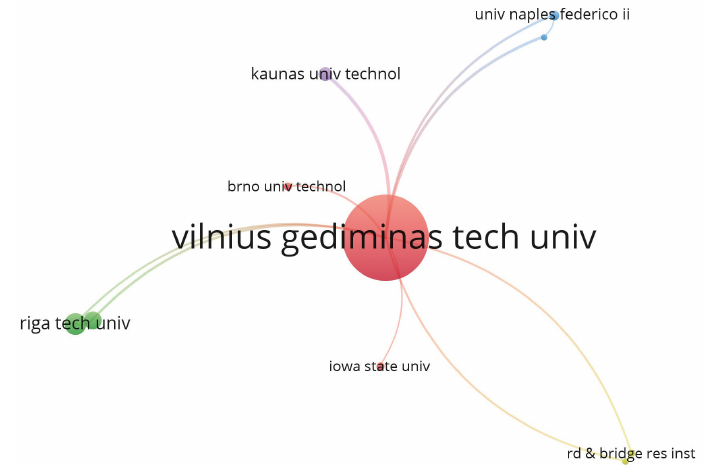
Figure 6. Organization co-authorship network of the Baltic Journal of